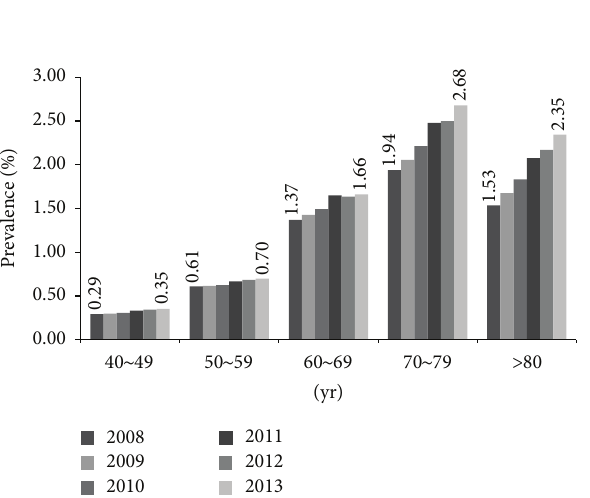
Figure 1: Prevalence of glaucoma in each age group. The prevalence of glaucoma significantly increased with age in Korean adults. The trend of increasing prevalence was statistically significant in older ( > 60 years)